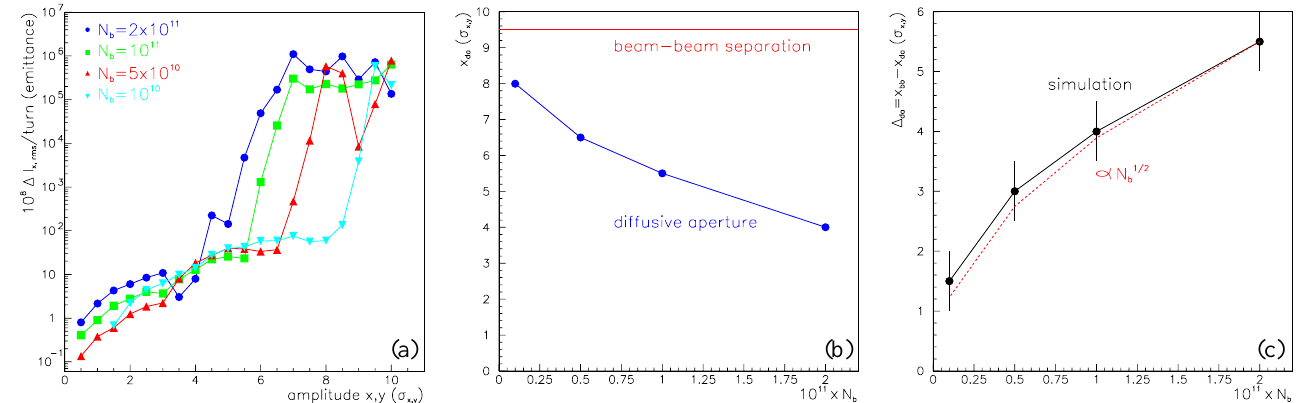
FIG. 14. (Color) Dependence of diffusion due to long-range collisions on the beam current. (a) The change of action variance per turn as a function of the bunch population, (b) approximate diffusive aperture as a function of the bunch population, and (c) same as the left picture, but the vertical axis is the distance to the other beam at the parasitic collision point. A square root dependence is also indicated for comparison.